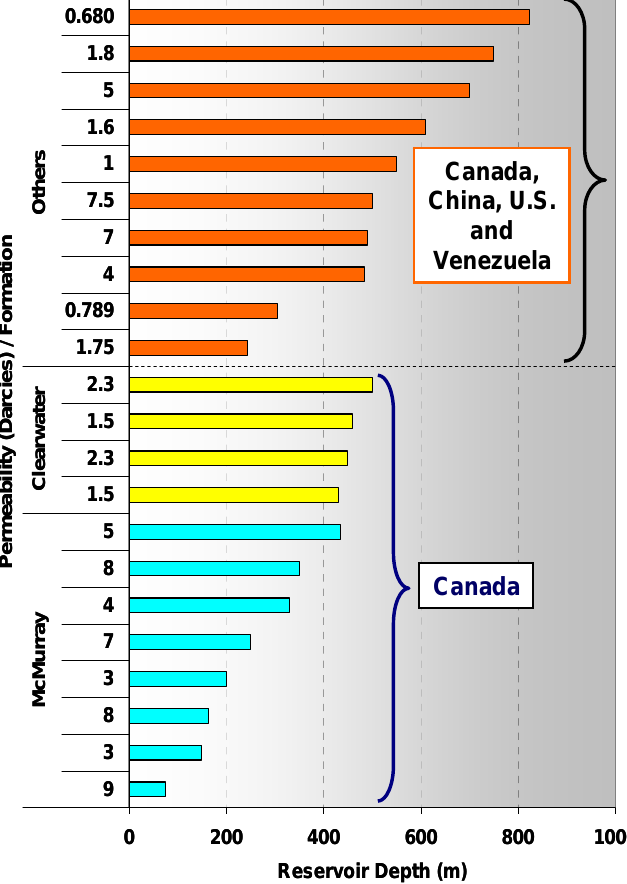
Figure 4. Depth, average permeability and formation of SAGD field